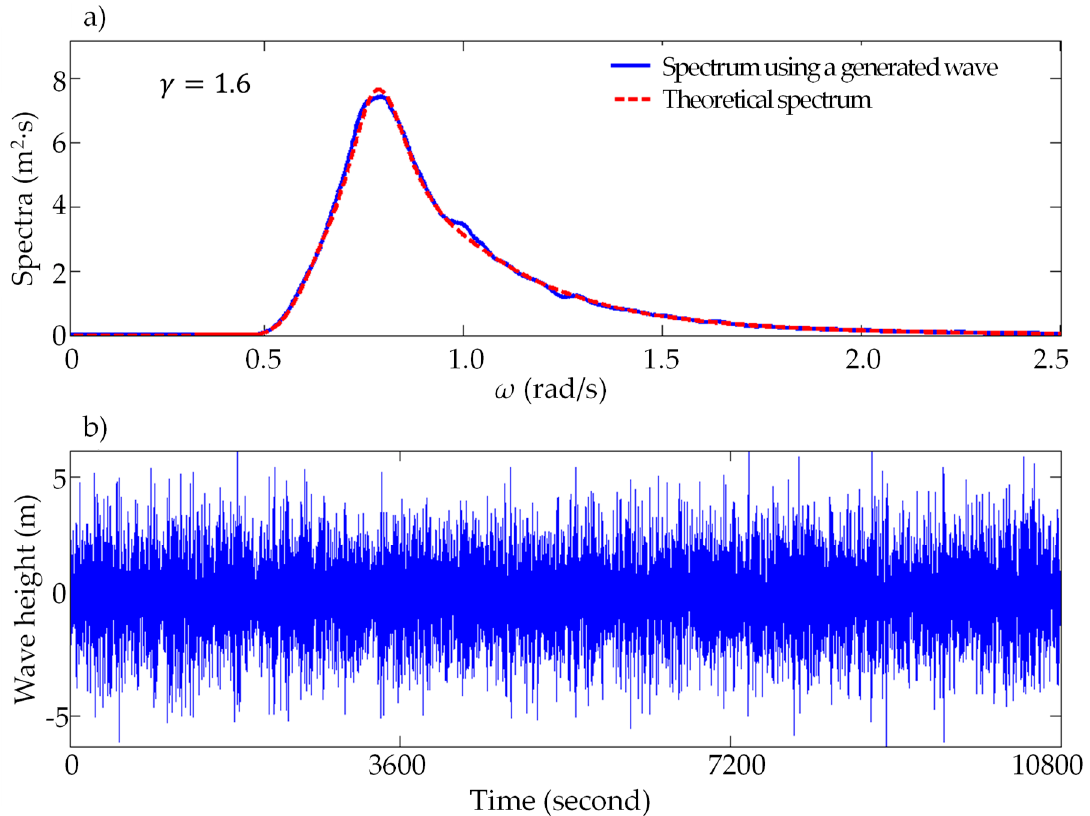
Figure 3. Comparison of the irregular wave height: ( a ) comparison between generated wave spectrum and theoretical spectrum, ( b ) irregular wave height (m) at the node located in the middle of the open boundary line .